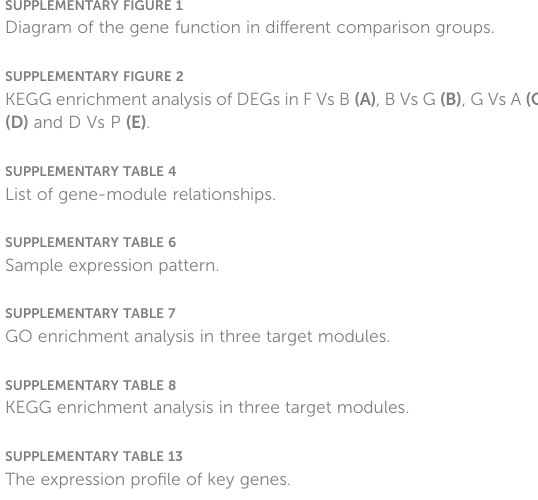
Diagram of the gene function in different comparison